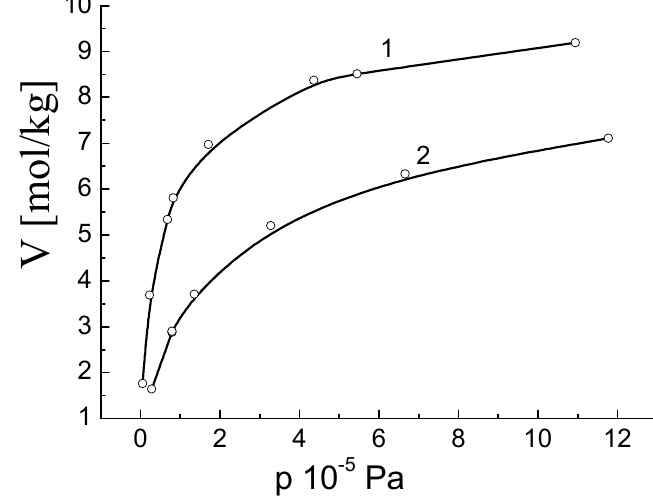
Figure 1. Adsorption isotherms of ethane on KF-1500 at 273.15 K (sample № 1) and at 323.15 K (sample № 2).